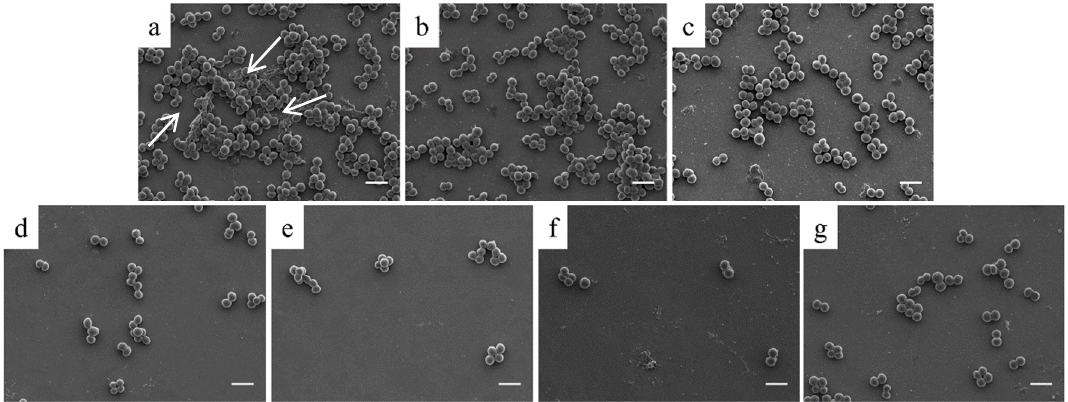
Figure 6. Representative SEM images of S. aureus adhering to Ti ( a ), Ti_PEG_cont ( b ), Ti_PEG_2.5_4 ( c ), Ti_PEG_5_4 ( d ), Ti_PEG_5_6 ( e ), Ti_PEG_5_8 ( f ), and Ti_PEG_7.5_4 ( g ). White arrows indicate the presence of an extracellular matrix characteristic of biofilm formation. Scale bar represents 2 µm .